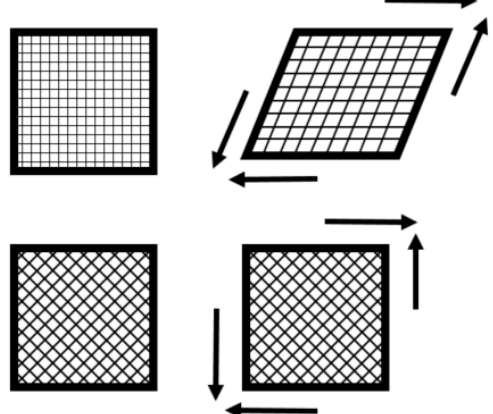
Figure 4. Shear deformation of the layers with different fiber orientations.